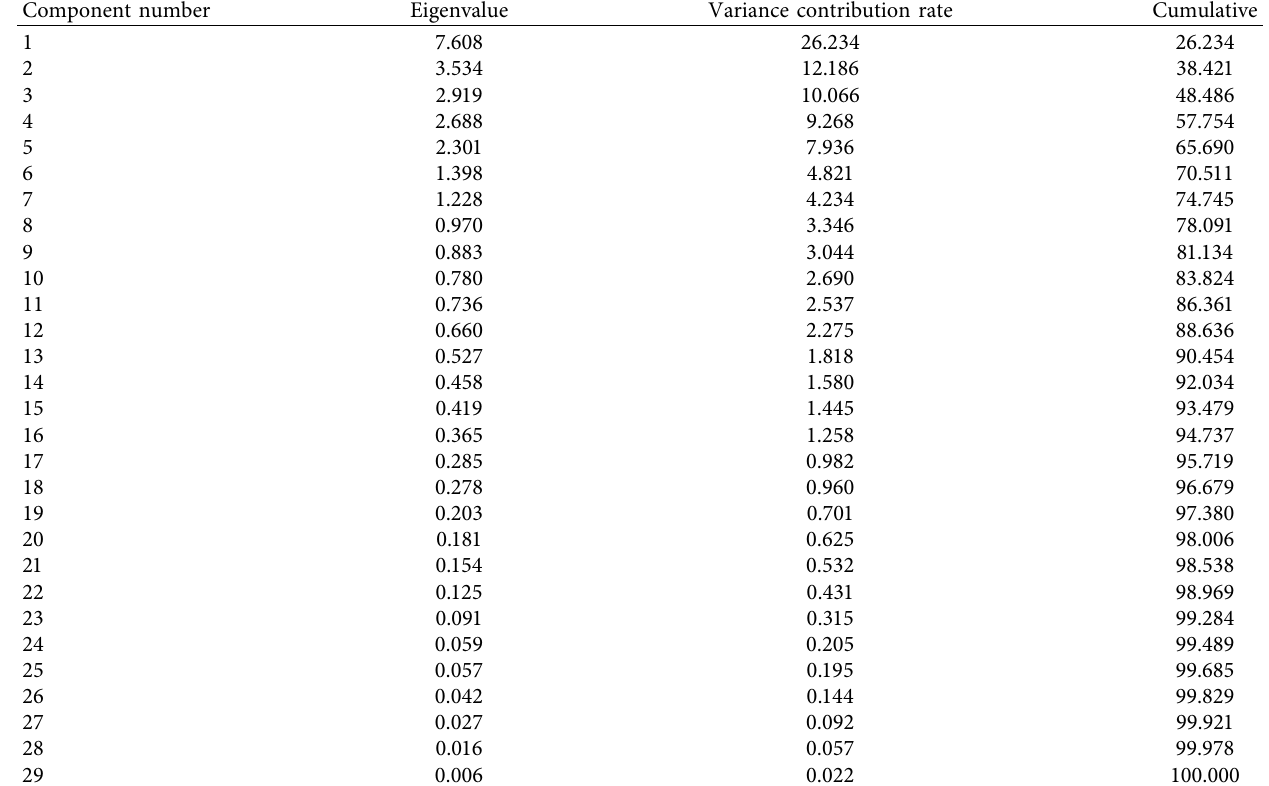
Table 4: Variance contribution rate and cumulative variance contribution rate of principal